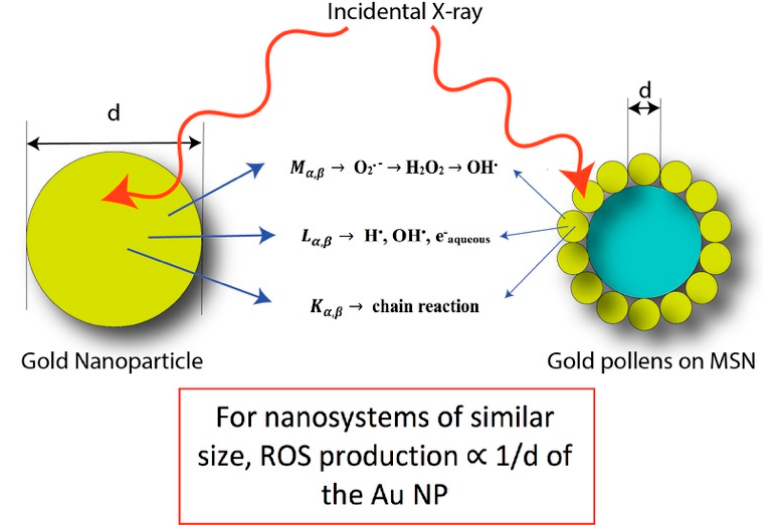
Figure 4. Graphical description of the production of reactive oxygen species (ROS) as a function of surface area and Au diameter, d.